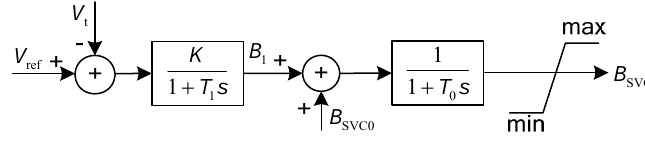
Figure 3. Dynamic model of SVC.